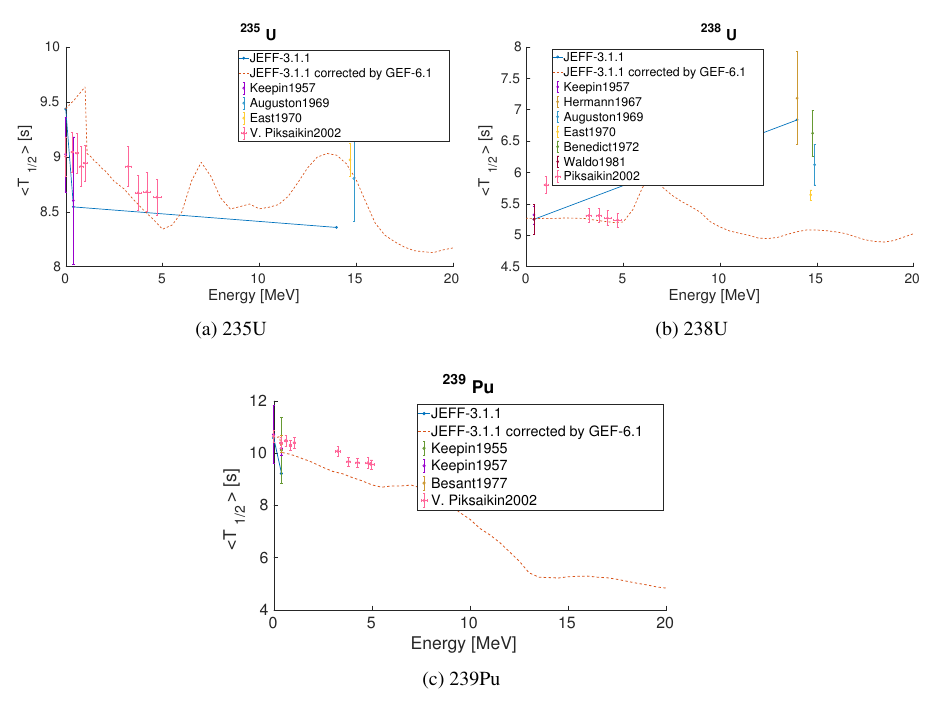
Figure 3: Energy dependence of the mean precursors’ half-life computed with the original JEFF-3.1.1 FY and with the with JEFF-3.1.1 FY modified with GEF-6.1 energy dependence. Experimental values are reported for